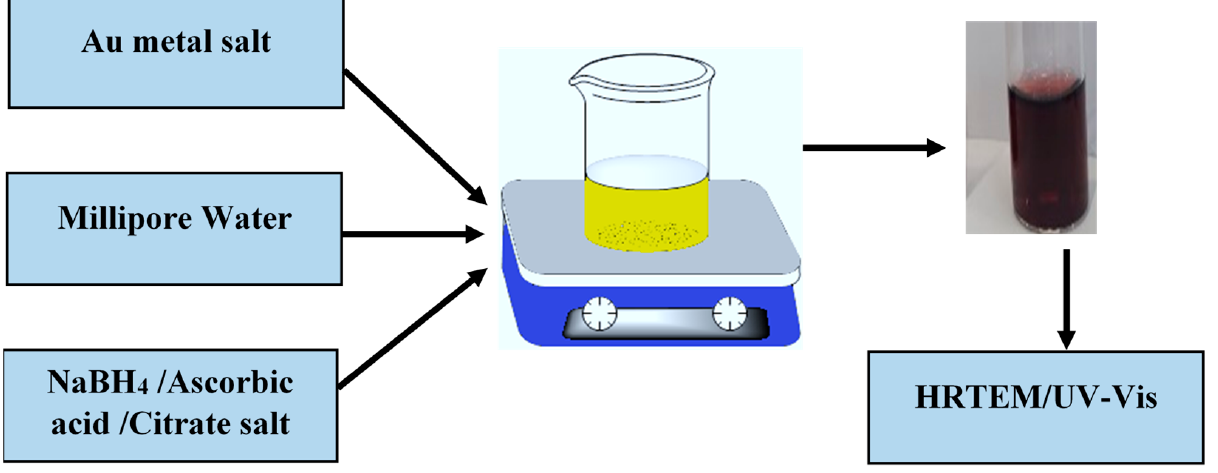
Figure 13. Synthesis of metal engineered nanoparticles using different reducing agents.